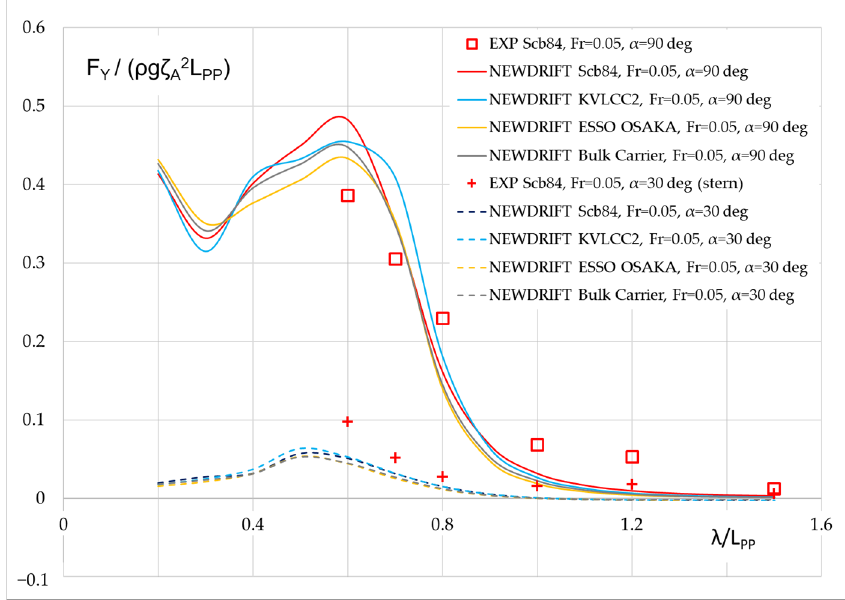
Figure 6. Mean sway force of various ships in regular beam and stern oblique waves at low speeds.